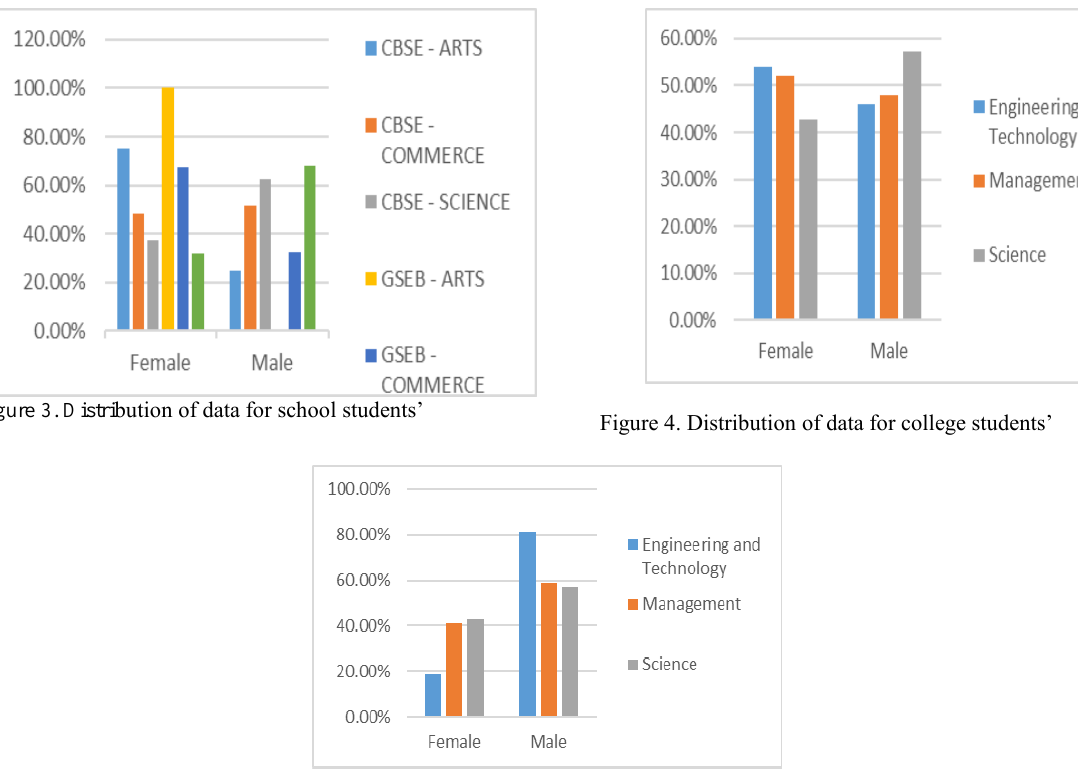
Figure 5. Distribution of data for